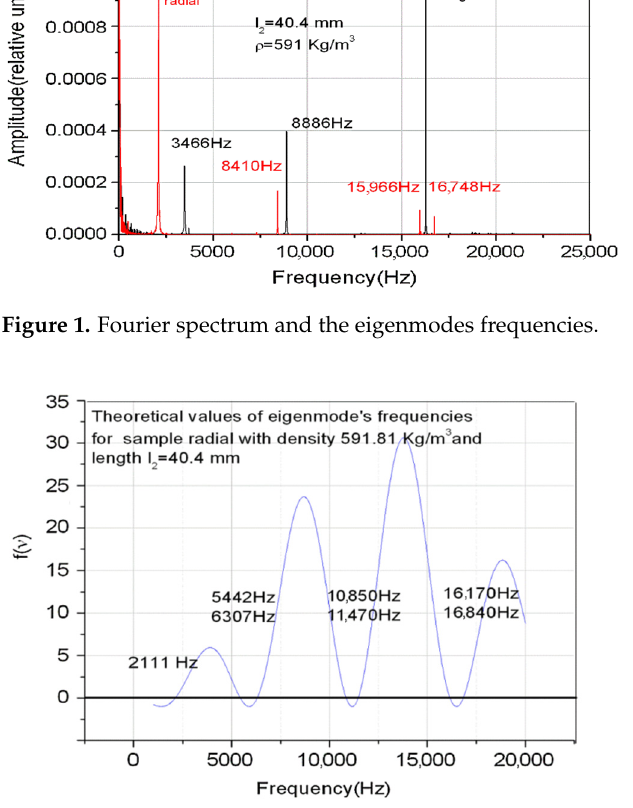
Figure 2. Theoretical eigenfrequencies for an aluminum-wood-aluminum system.